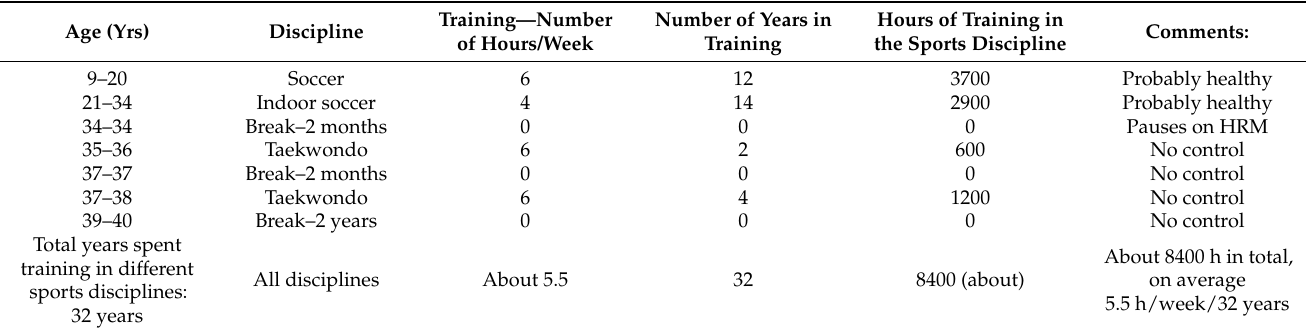
Table 1. Involvement in individual sports of the examined amateur